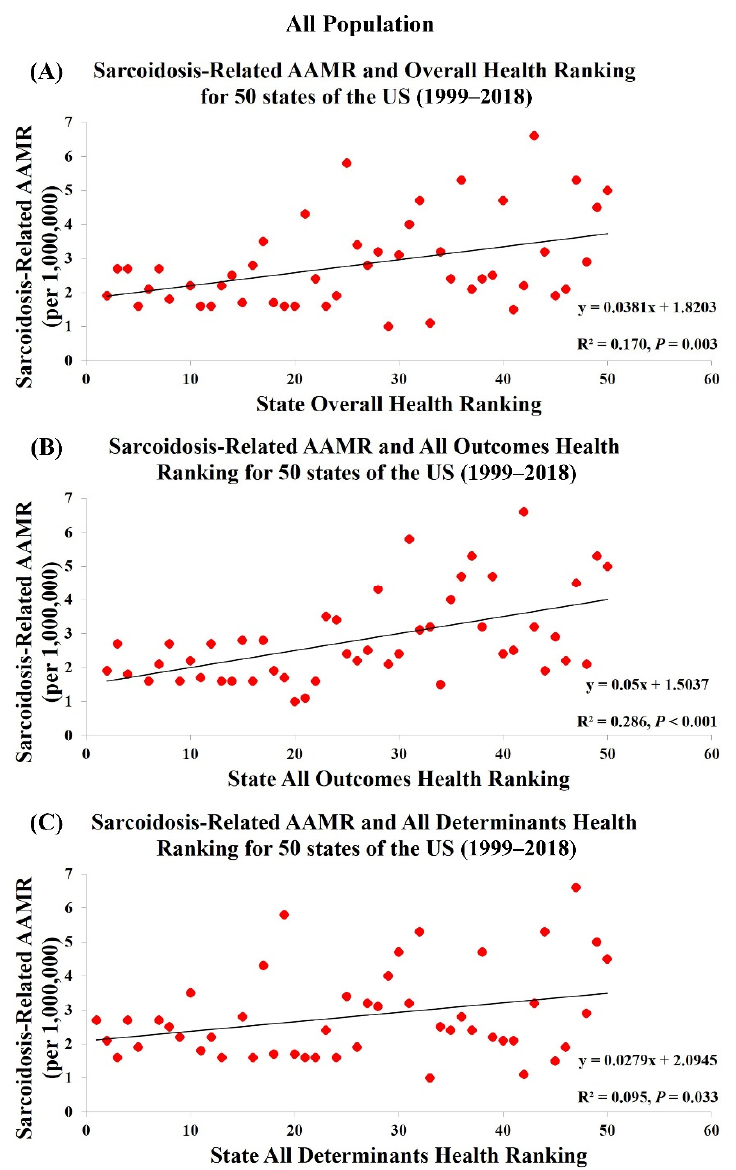
Figure 2. Sarcoidosis-Related AAMR in All Population are significantly associated with ( A ) Overall Health Rankings, ( B ) All Outcomes Health Rankings, and ( C ) All Determinants Health Rankings.